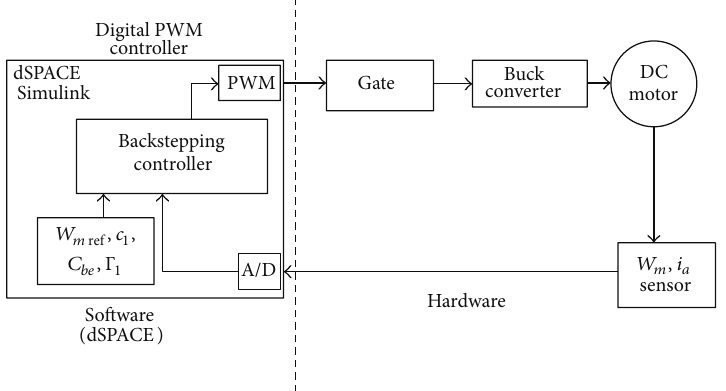
Figure 1: Block diagram of the proposed